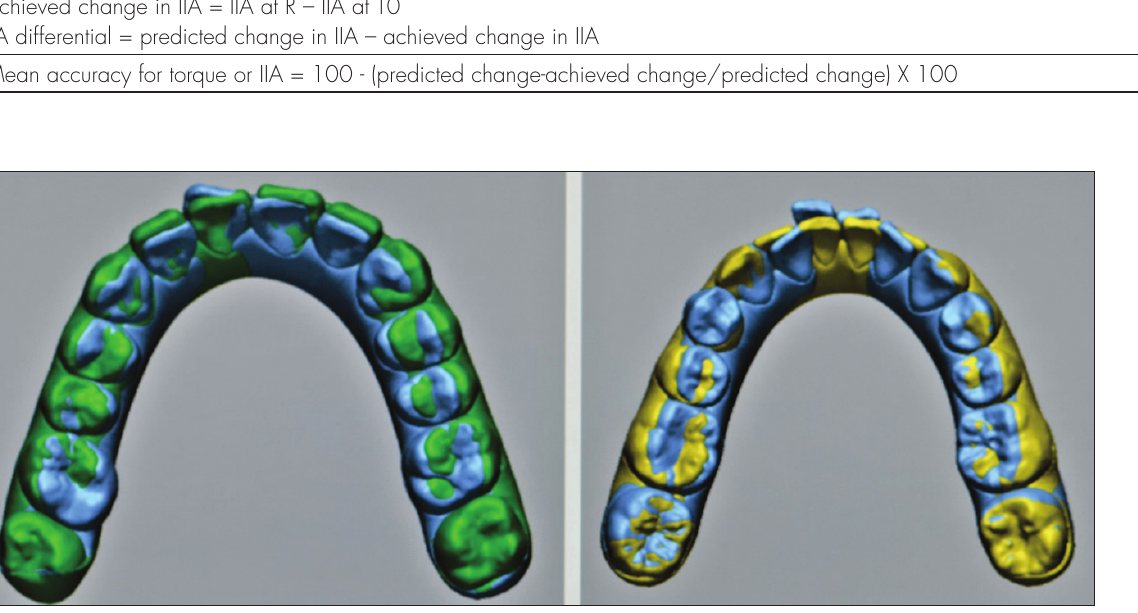
Figure 4. Best-fit superimposition (global and